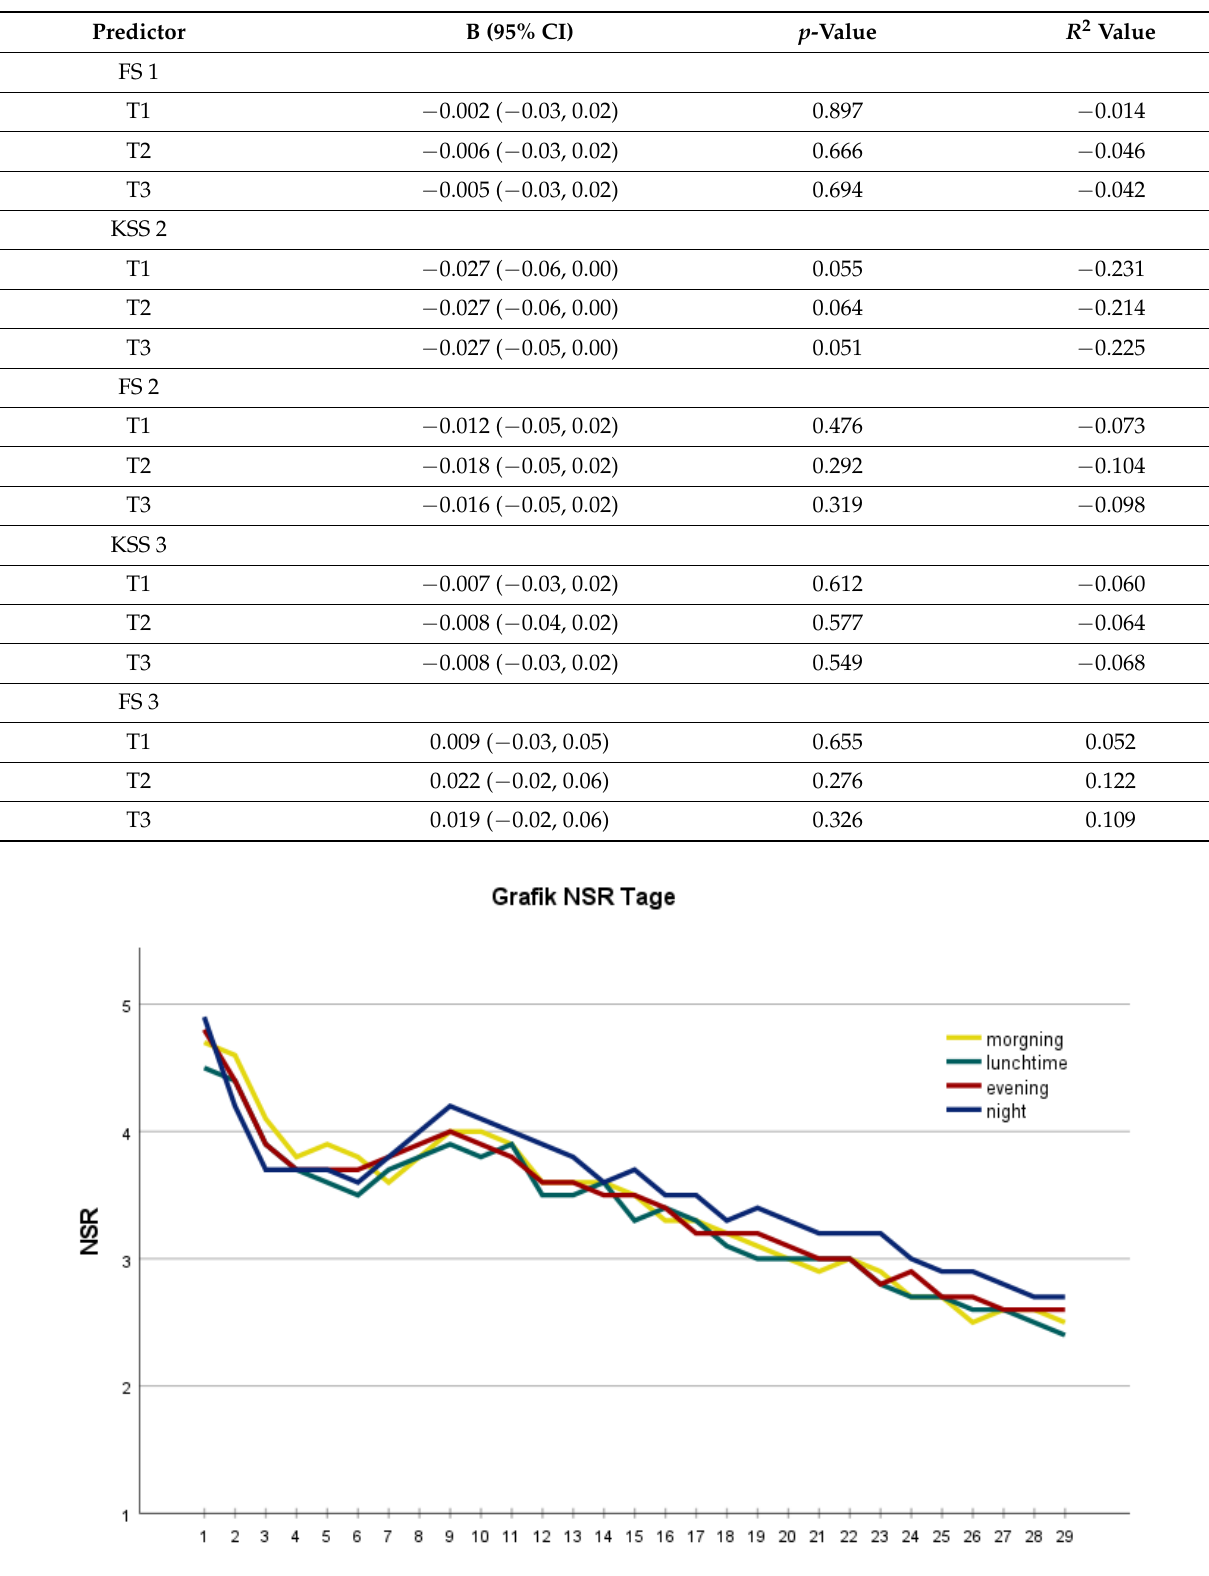
Figure 1. Graph represents the mean pain and maximum pain on days 1–29 on an NRS scale. The mean pain calculation is based on morning, lunchtime, evening, and nighttime pain values.